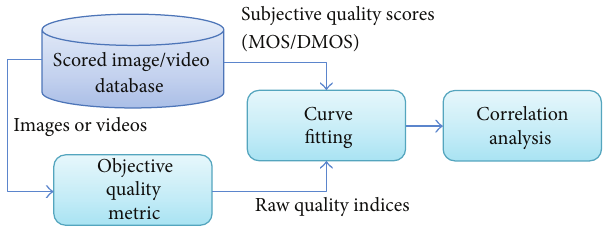
Figure 3: Block diagram of the QAM evaluation process.